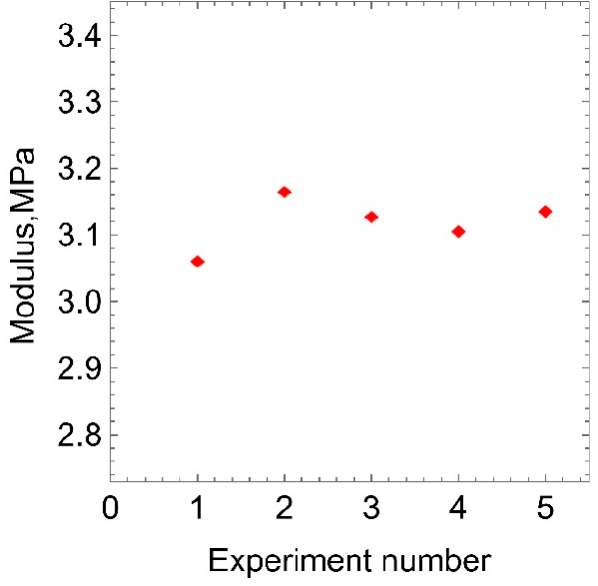
Figure 7. The values of elastic modulus obtained in a series of five experiments for an untreated sample of polyurethane.